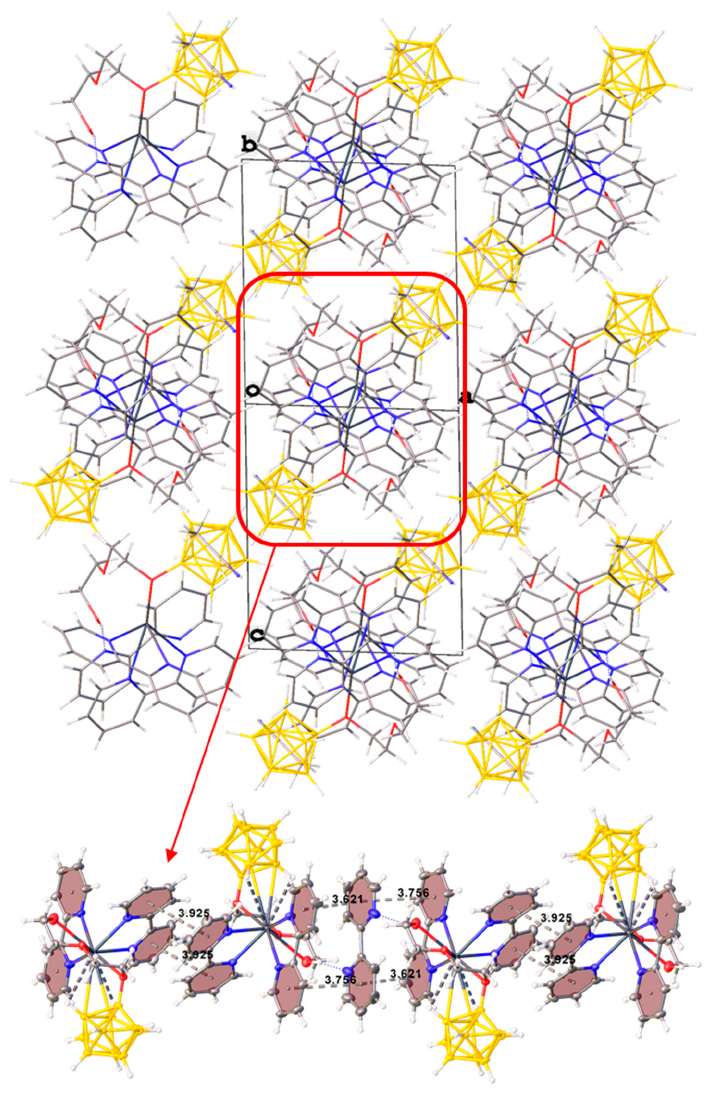
Figure 4. Packing diagram of 2 · 0.5bipy · CH 3 CN and π – π stacking interactions in the crystal. The crystallographically independent part of the monoclinic unit cell of complex 3 is built of the monomeric unit [Pb(bipy)[B 10 H 9 O(CH 2 ) 5 O(CH 2 ) 2 OH]] of the polymer complex Table 3. Metal–heteroatom distances in complex 3 and two faces B1B3B4 and B6B9B10 from two adjacent boron cages. The Pb–X distances are given in Table 3. Thus, three di ff erent [B 10 H 9 O(CH 2 ) 5 O(CH 2 ) 2 OH] 2 − anions are co-ordi- nated by each metal atom, resulting in the formation of 2D polymer networks parallel to